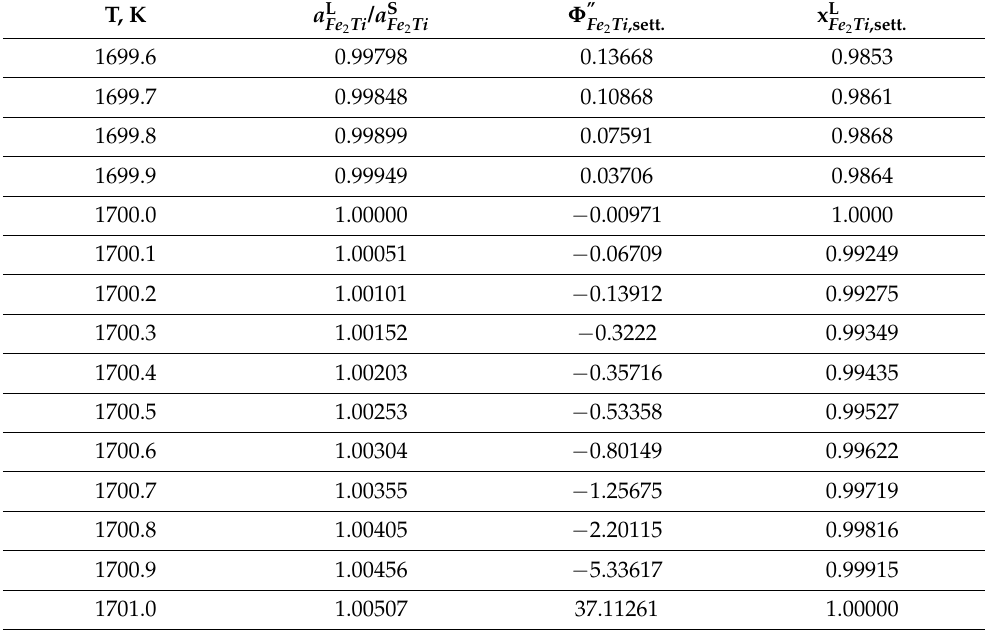
/ a S Fe 2 Ti Fe 2 Ti